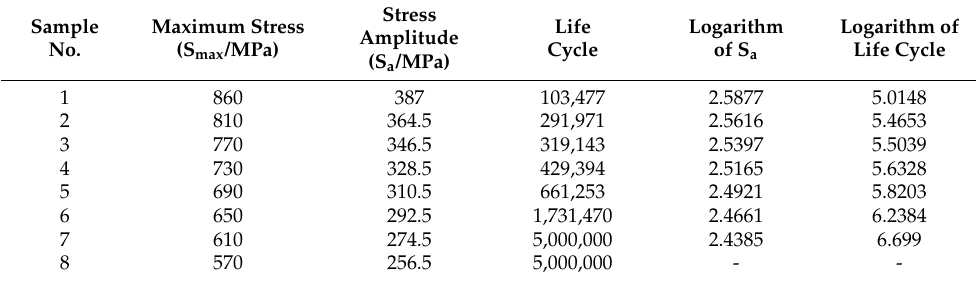
Table 3. Fatigue test